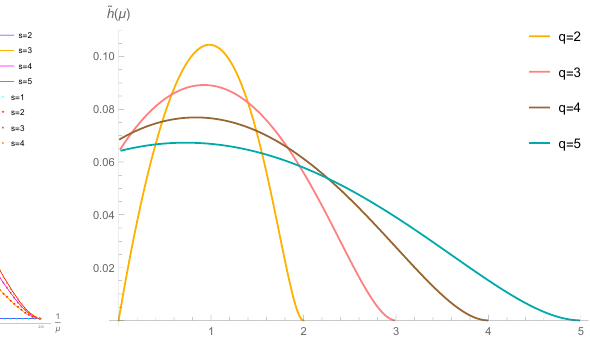
(b) The q 6 = 2 cases. The curves are the anoma- lous dimension of the spin s = 3 operator as a function of (cid:22) . The operator has nonvanishing anomalous dimension and are not conserved as (cid:22) ! + 1 . The behavior of the operators in the antisymmetric channel are similar.